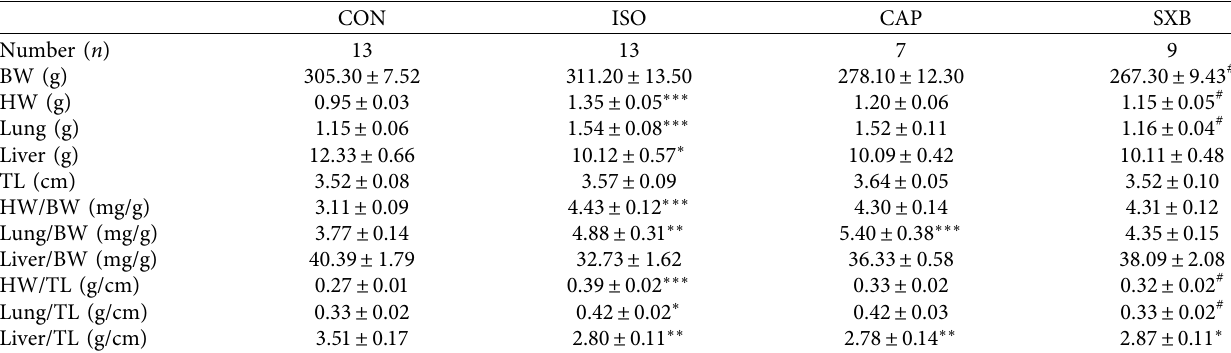
Table 2: Anatomic data among CON, ISO, CAP, and SXB